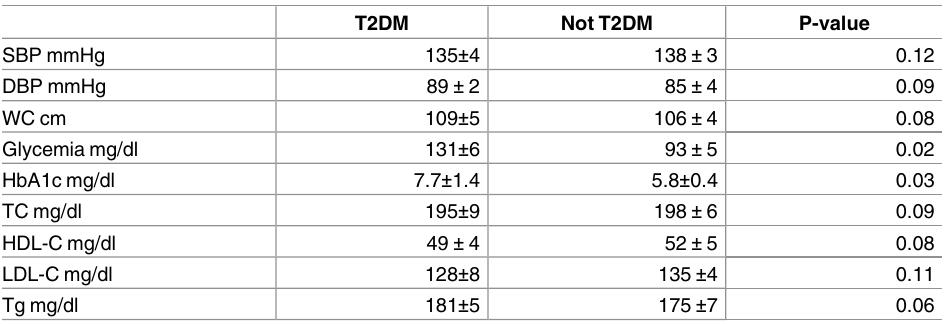
Table 1. Baseline characteristics.